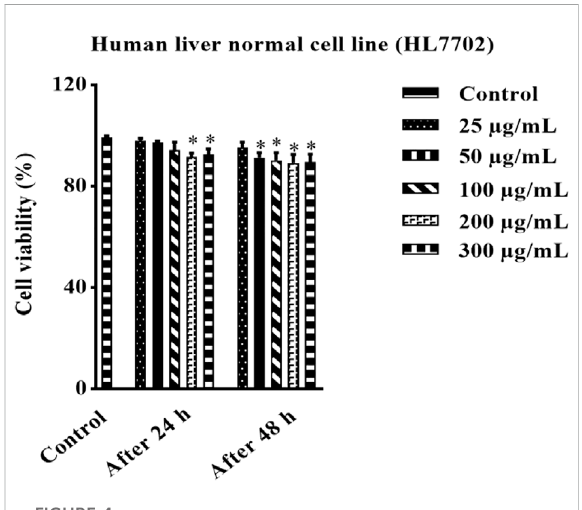
FIGURE 4 Effect of HAECA on human normal liver cells.